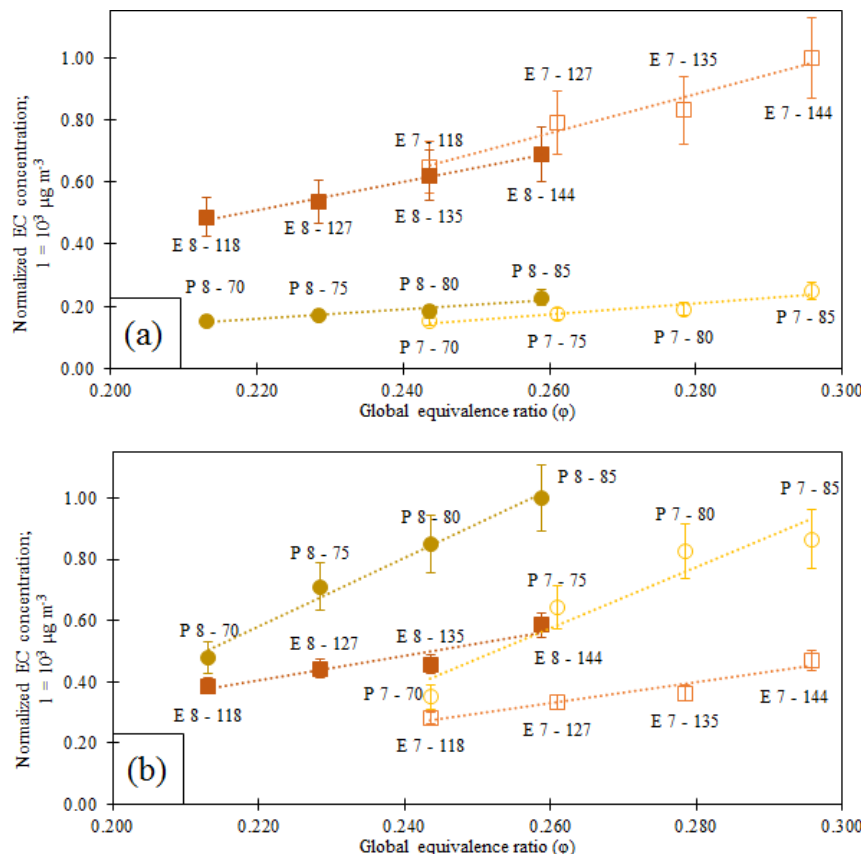
Figure 9. EC mass concentration vs. the global equivalence ratio. Each value was normalized to the highest of the whole set. Each point is labelled with E or P (ethylene or propane) and a pair of numbers indicating air and fuel flow rate, respectively (Lmin − 1 ; mLmin − 1 ). (a) No cyclone. (b) Cyclone upstream of the filter. Dotted lines aim to guide the reader’s eye.